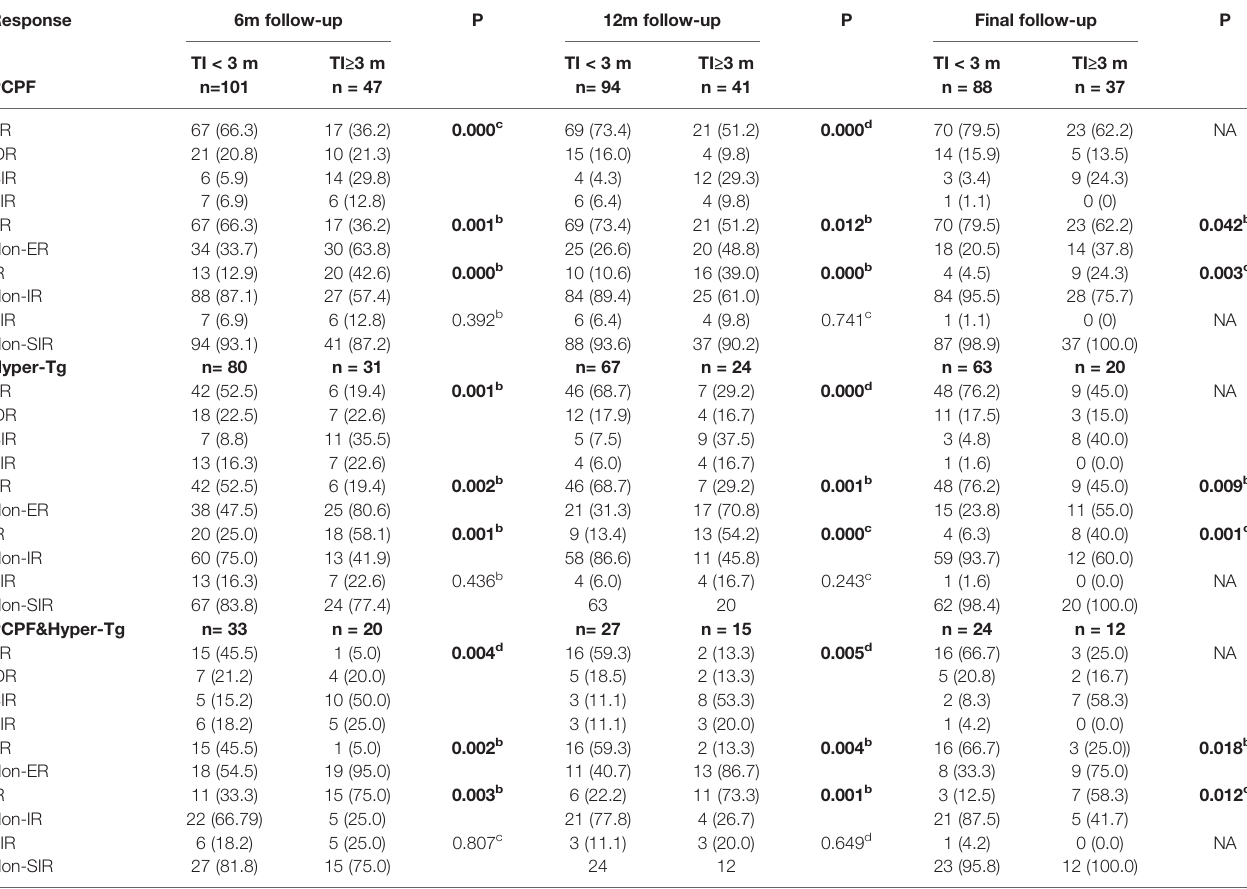
TABLE 3 | Comparison of responses to initial RAT between 2 groups in sub-groups [n (%)].